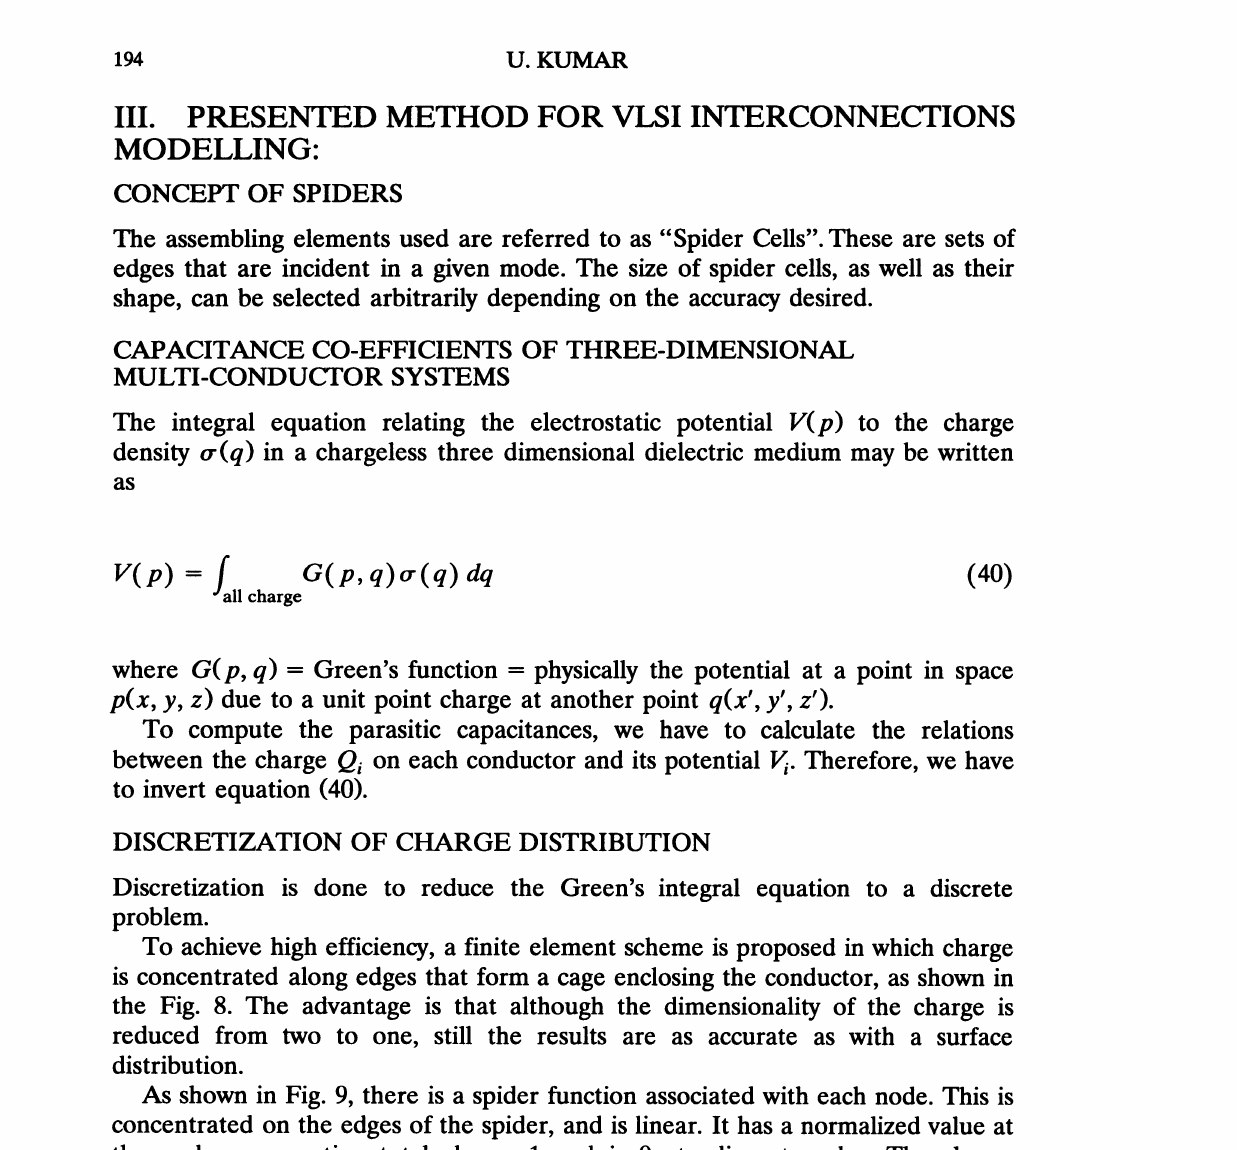
FIGURE 8 Number of edges for different spiders for